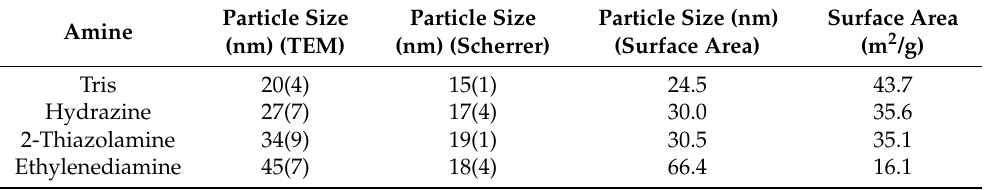
Figure 4. X-ray powder diffraction data for ZnO nanomaterials prepared using [Zn(acetate) 2 (amine) x ] precursors by alkali precipitation in water/methanol solutions at 65 ◦ C. The labels are the amine on the precursor during synthesis. The average particle size given is that observed with the TEM measurements. Size and surface area of the ZnO nanoparticles produced using the different [Zn(acetate) 2 (amine) x ] precursors during rapid precipitation in methanol/water solutions. Sizes are average sizes measured with the TEM, and calculated with the Scherrer and surface area equations. Standard deviations for measurements are provided in